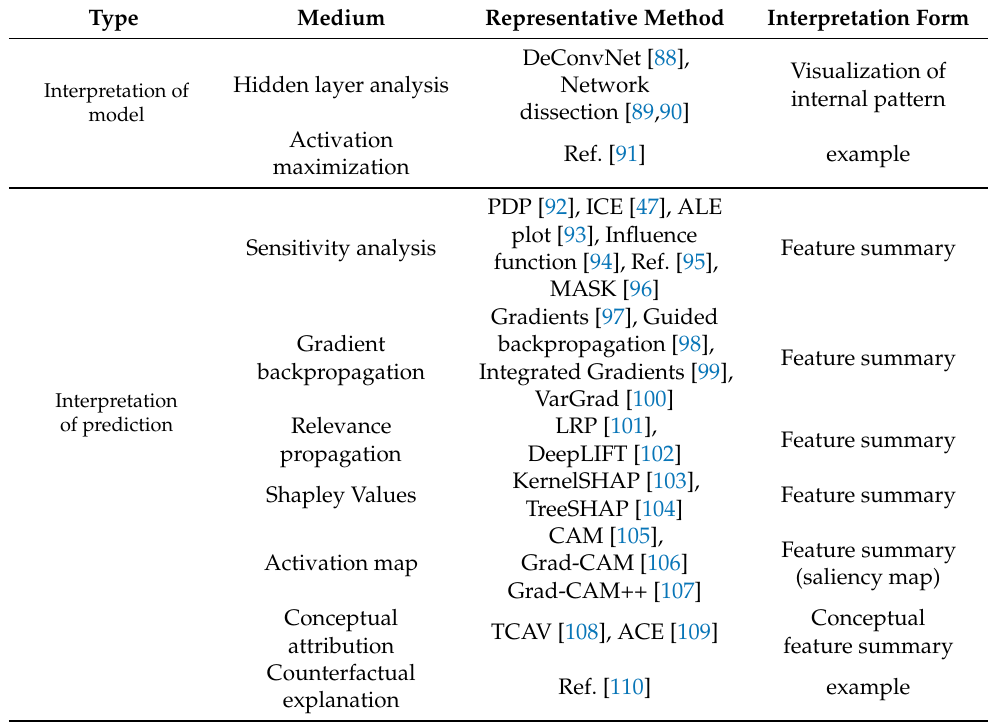
Table 1. Summary of post-model interpretability